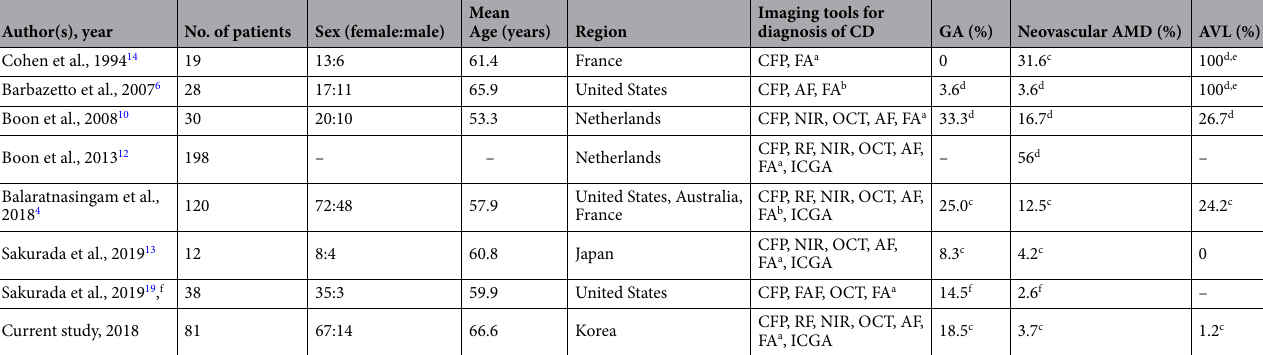
Table 3. Comparison of recent cuticular drusen studies. – unknown, AF fundus autofluorescence, AMD age-related macular degeneration, AVL acquired vitelliform lesion, CD cuticular drusen, CFP color fundus photography, FA fluorescein angiography, GA geographic atrophy, ICGA indocyanine green angiography, NIR near-infrared, OCT optical coherence tomography, RF red-free imaging. a FA was performed in all patients. b FA was performed in selected patients. c % of eyes. d % of patients. e Patients who had both vitelliform or pseudovitelliform detachment and cuticular drusen were included. f Baseline cross-sectional data before exclusion.